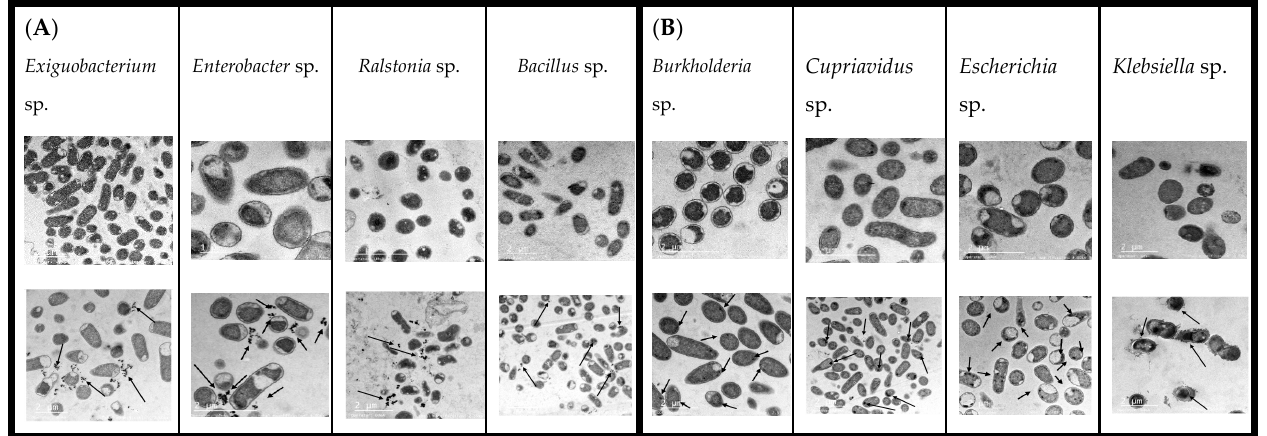
Figure 2. Some TEM pictures for cells without Cd (up), cell tolerance to 15 mg Cd/L (below). ( A ) Biosorption ability; the black arrows indicated external deposits of Cd. ( B ) Intracellular ability; the black arrows indicated intracellular deposits of Cd.